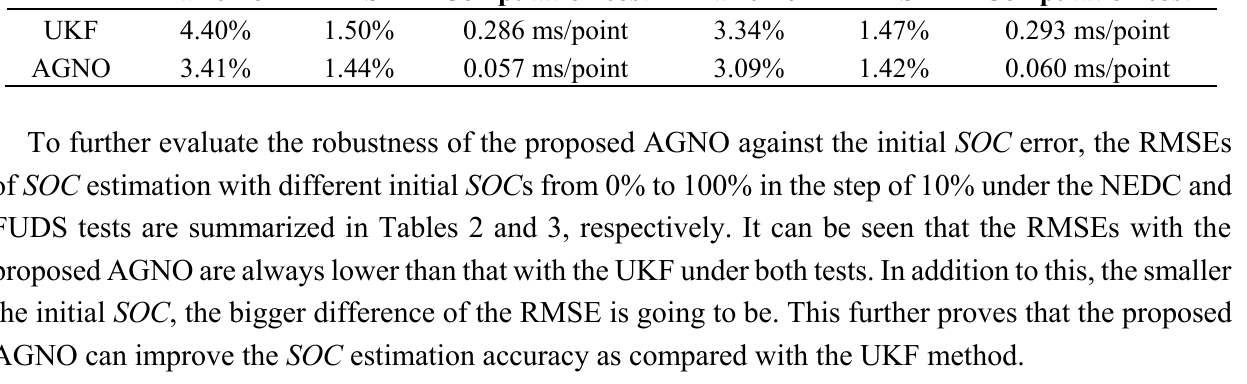
Table 1. Comparison of SOC estimation and computation cost. RMSE: root mean square error. Methods